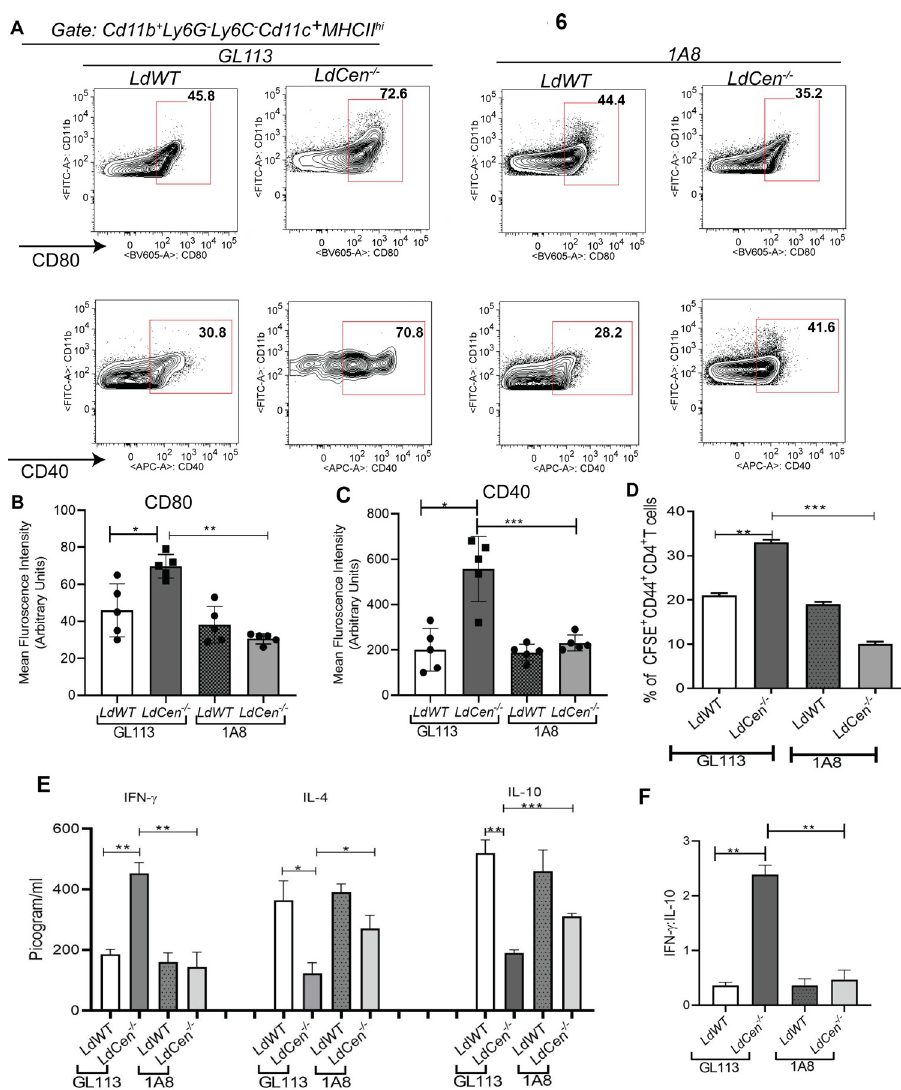
Fig 6. Neutrophil depletion abrogates DC mediated CD4 + Th1 cell priming during LdCen -/- infection. (A) The expression of CD80 and CD40 in the DCs recruited in ear dLN of GL113/1A8 treated infected mice were analyzed by flow cytometry and represented by the flow plots. (B, C) The Mean fluorescence intensity ( MFI) of the costimulatory molecules (CD80, CD40) expression in ear dLN has been represented by the bar diagram. The data represent the mean values ± SD of results from three independent experiments that all yielded similar results (n = 5). � p < 0.05; �� p < 0.005 ��� p < 0.0005. (D) Parasitized DCs were flow sorted from the ear dLN of GL113/1A8 treated infected mice. Ag-specific CD4 T cell proliferation was estimated from DC-CD4 T cell coculture assay by studying CFSE dilution of gated CD4 + CD44 + T cells and is represented by the bar diagram. Cell proliferation was analyzed in triplicate experiments (n = 6). (E) The culture supernatant fluids were collected and assayed for IFN- γ (Analytical sensitivity: 15 pg/mL; Assay range:15–2,000 pg/mL) IL-4 (Analytical sensitivity: 4 pg/mL; Assay range: 4–500 pg/mL and IL-10 (Analytical sensitivity: 30 pg/mL, Assay range: 30–4,000 pg/mL) by ELISA. (F) IFN- γ /IL-10 ratio was determined. The data represent the picogram levels of cytokines in culture supernatants and are presented as means ± SD from three independent experiments that all yielded similar results (n = 6). � p < 0.05; �� p < 0.005 ��� p <